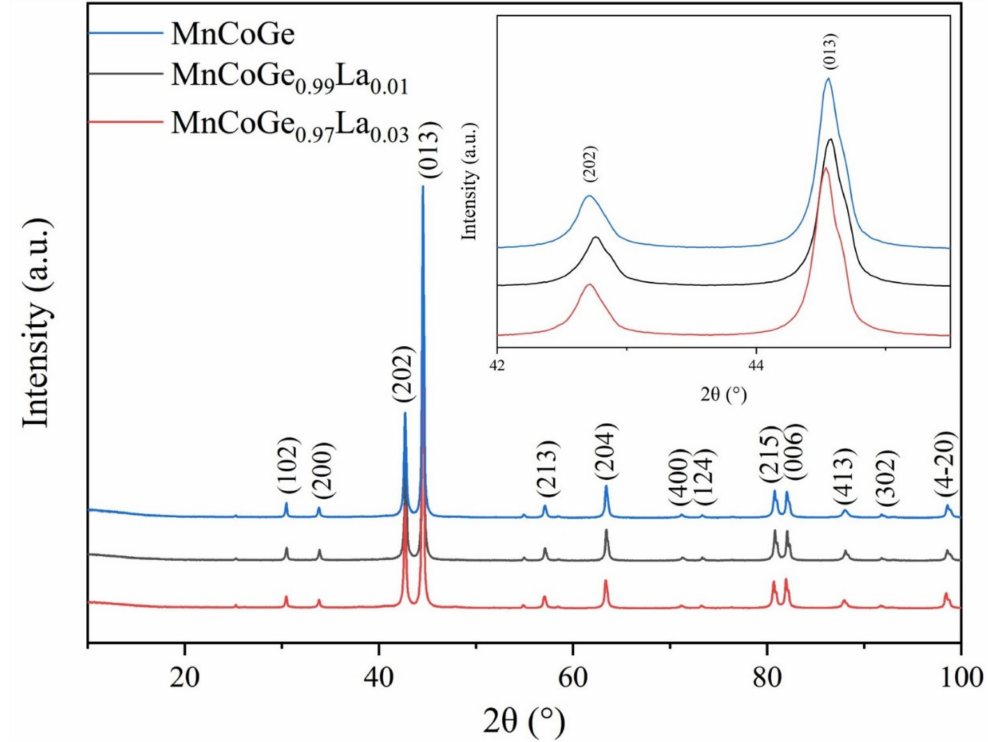
Figure 1. XRD pattern of MnCoGe 1 − x La x alloy at room